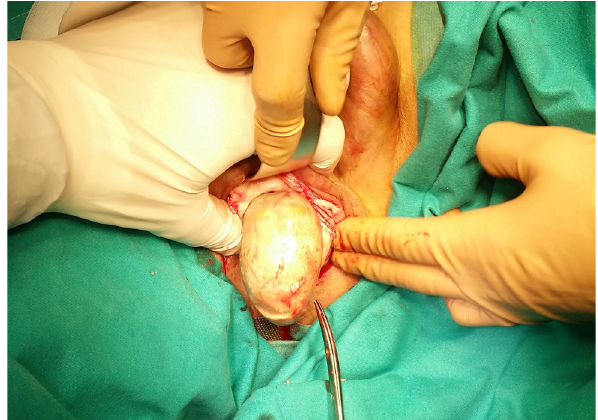
Figure 2: Final stage of the operation.